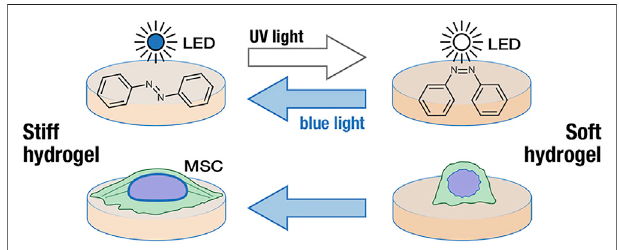
FIGURE 1 | Changes of hydrogel stiffness under blue and UV light irradiation (Lee et al., 2018b). Reprinted (adapted) with permission from (Lee et al., 2018b).Copyright 2018 – 2021 American Chemical